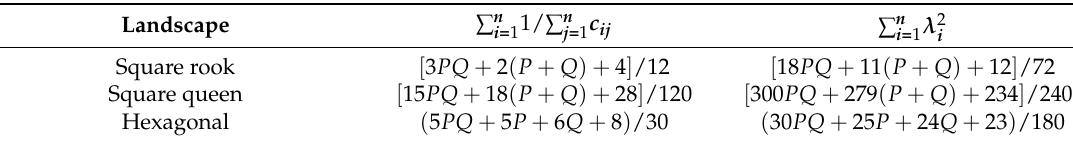
Table A1. Components of the denominator of Equation